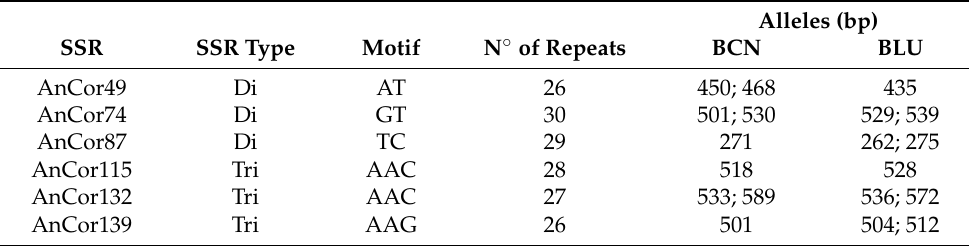
Table 2. List and primer sequences of the six candidate markers for cultivar discrimination analyses between BCN and